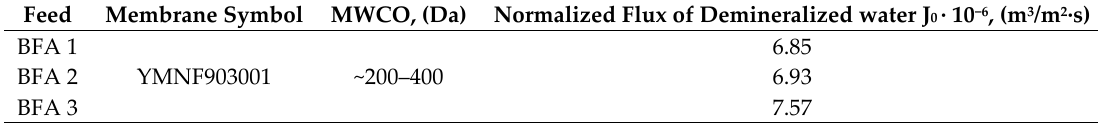
Table 3. Characteristics of membranes and operating parameters of the process. Feed Membrane Symbol